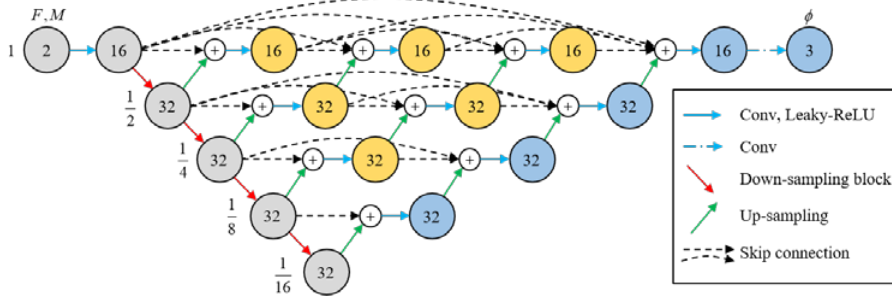
Fig. 2. Proposed architecture VoxelMorph++. Each circle represents a 3D volume. The number of channels is shown inside the circle. All 3D volumes in the same horizontal direction have the same spatial resolution, which is printed at the beginning of each row with respect to the input